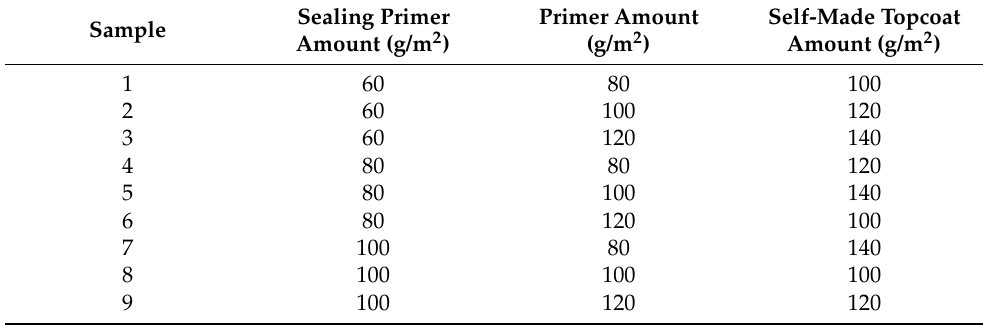
Table 2. Coating amount scheme.